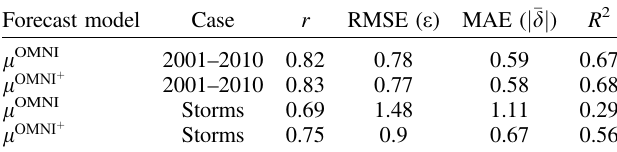
Table 4. Table showing the prediction summary of the l OMNI and l OMNI þ models during 2001 – 2010 and geomagnetic storms listed in Table 3. Forecast